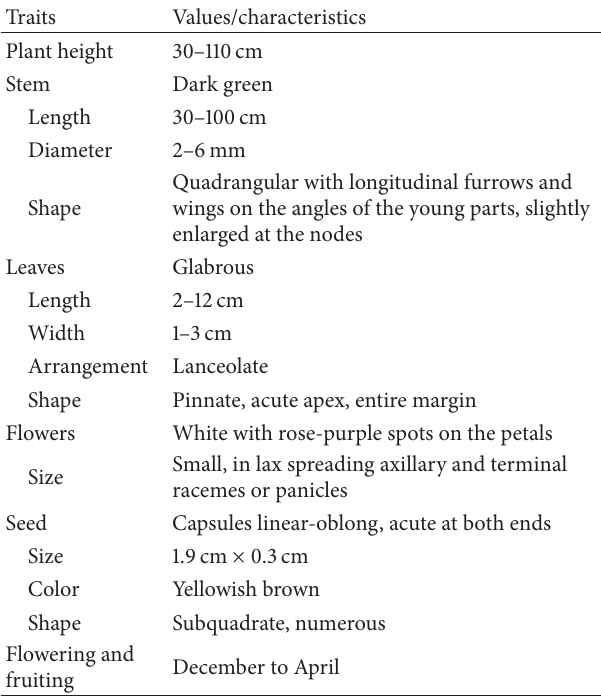
Table 1: The morphology and physiology of A. paniculata [10, 62,